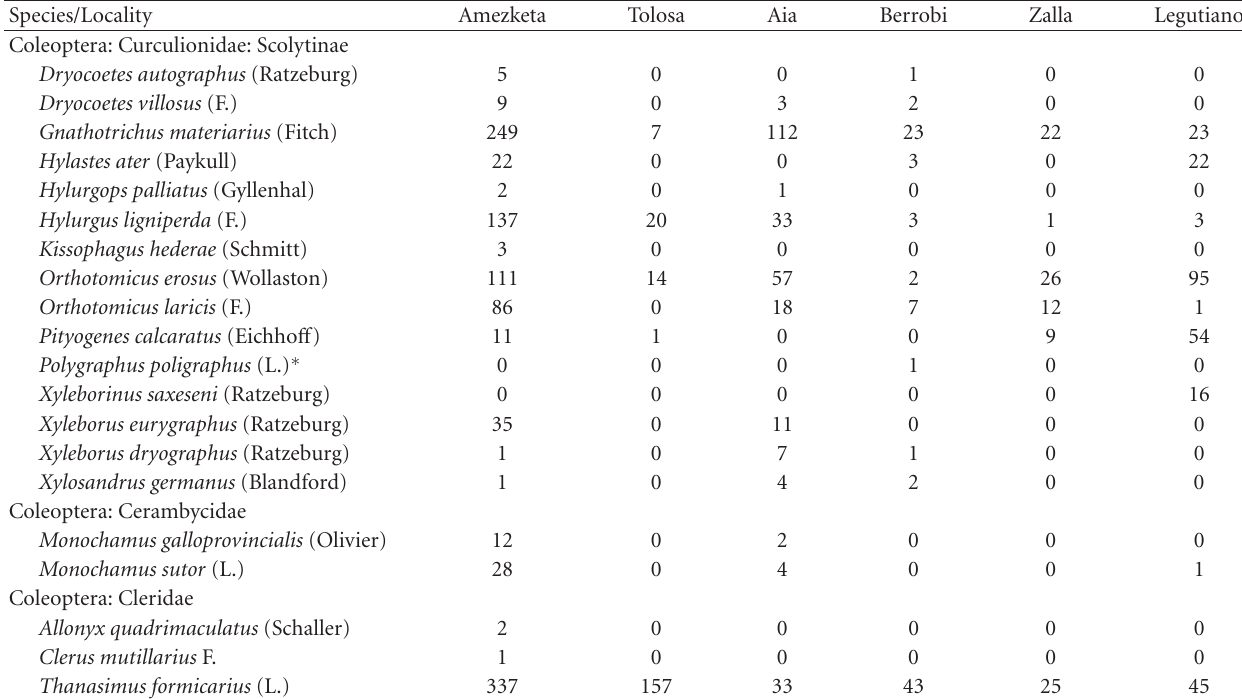
Table 2: Total number of accidentally trapped species of bark and ambrosia beetles (Curculionidae: Scolytinae), cerambycid (Cerambycidae) and checkered beetles (Cleridae). Species within family/subfamily are sorted by alphabetical order. Species/Locality Coleoptera: Curculionidae: Scolytinae